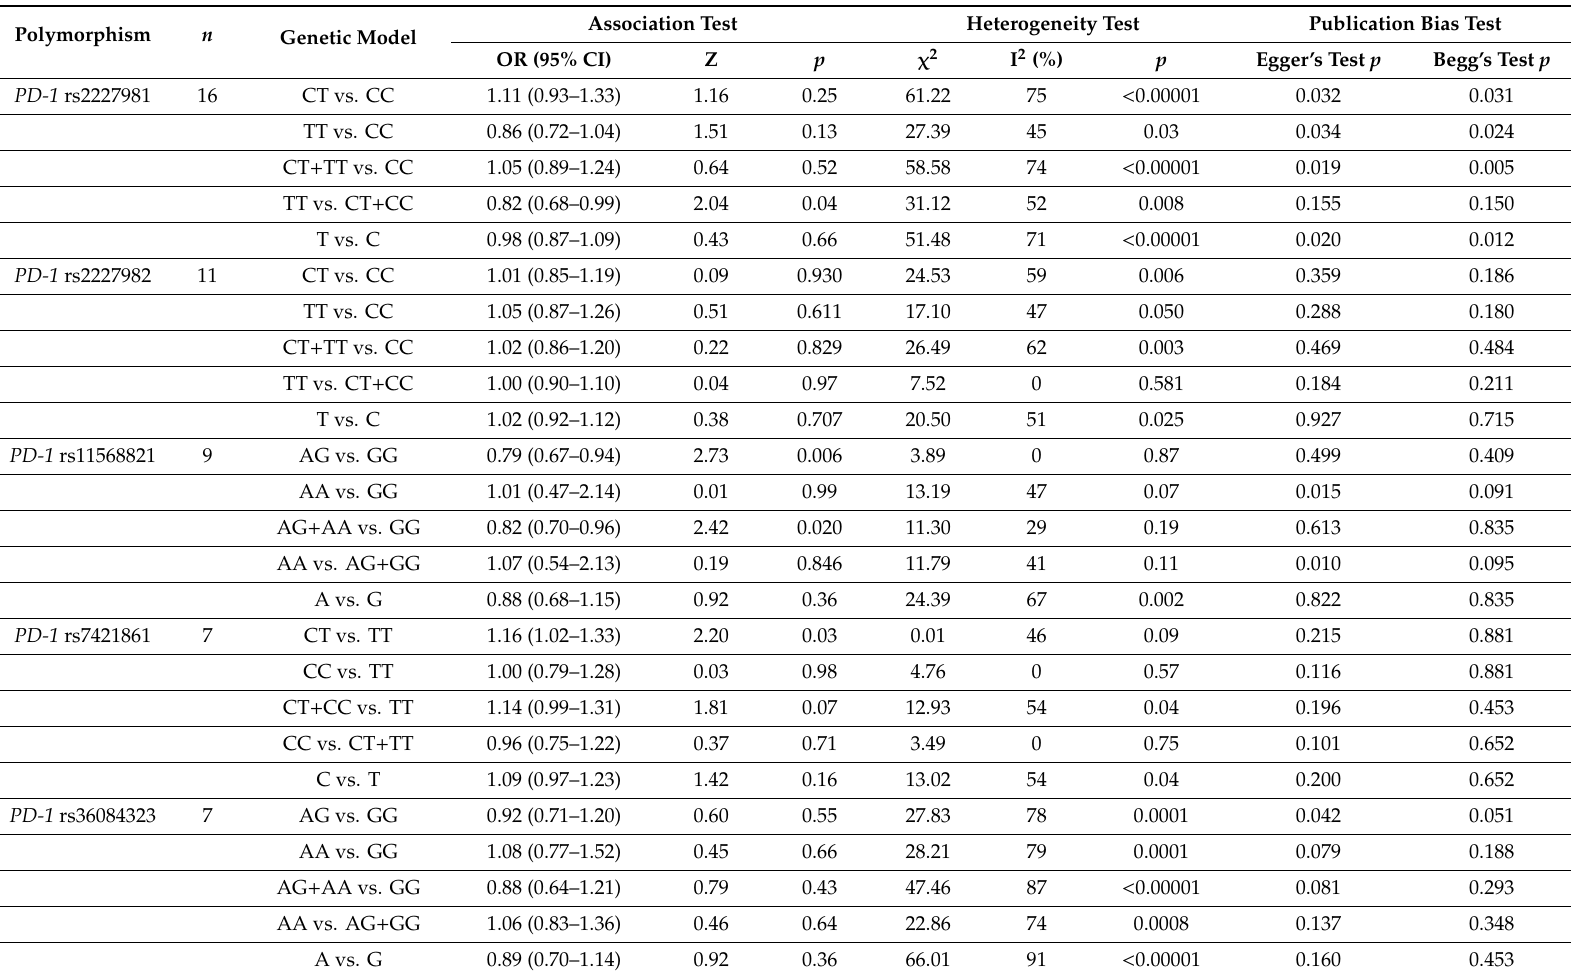
Table 3. The pooled ORs and 95% CIs for the association between PD-1 and PD-L1 polymorphisms and cancer